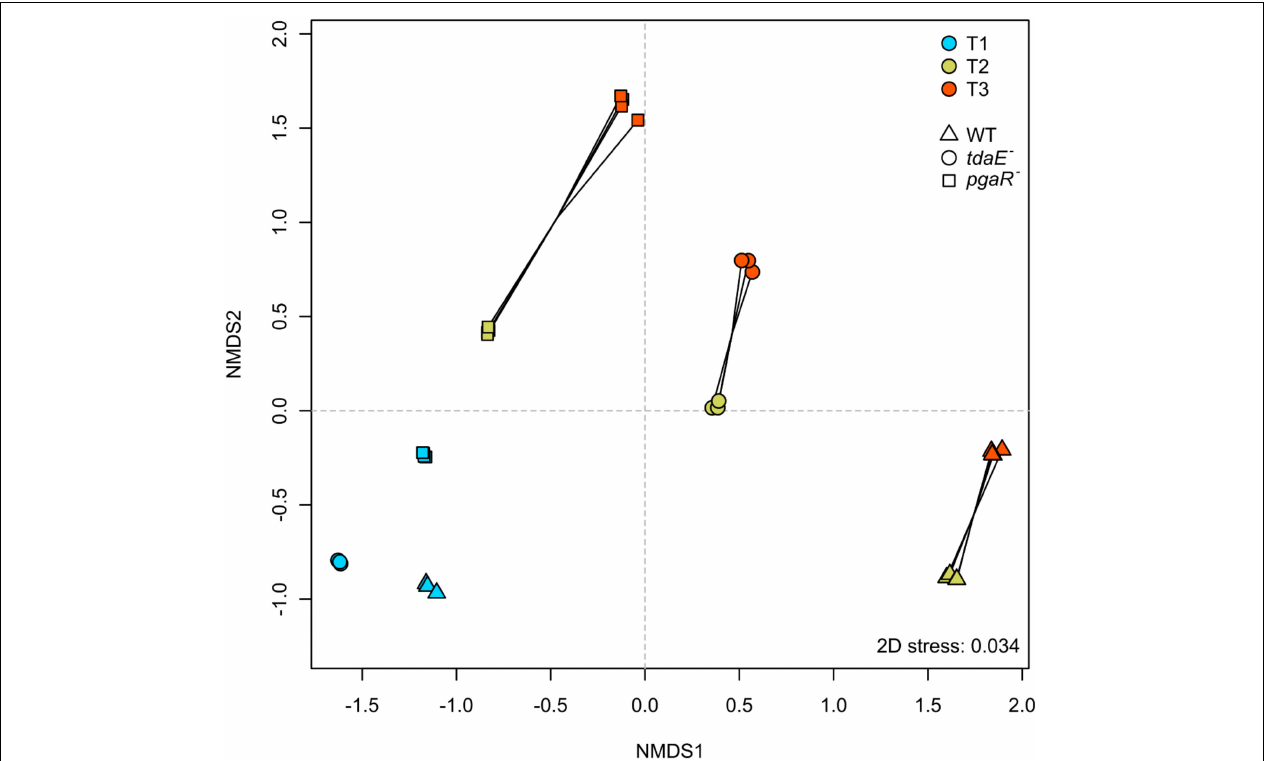
FIGURE 2 | Similarity among the exometabolome samples of P. inhibens DSM 17395 wild type (WT), tdaE − mutant and pgaR − mutant over time. Non-metric multidimensional scaling (NMDS) was performed for the filtered dataset using Bray-Curtis similarity index. Stress value for the plot is 0.034. All biological replicates of each strain at each sampling point are shown. Color code indicates sampling time points; T 1 in blue, T 2 in green and T 3 in red. Symbols represent the strains; triangle for WT, square for pgaR − and circle for tdaE − .